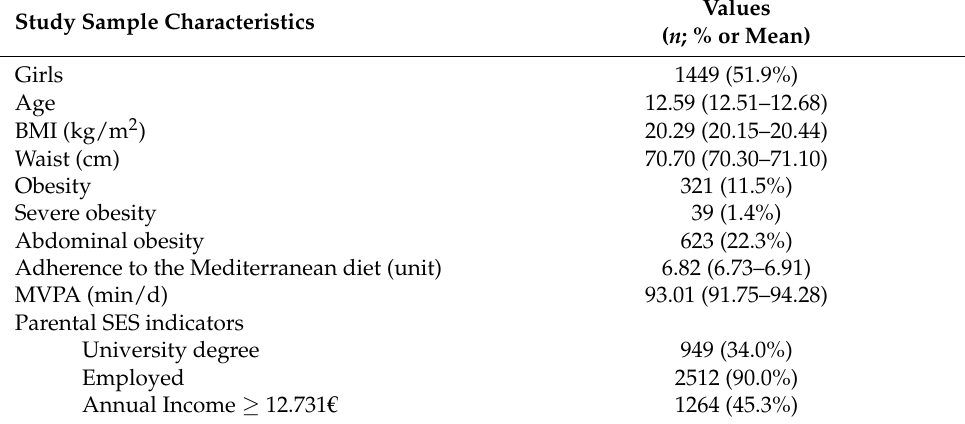
Table 1. Characteristics of the study population ( n = 2791)–PASOS study. Spain, 2019–2020. Study Sample